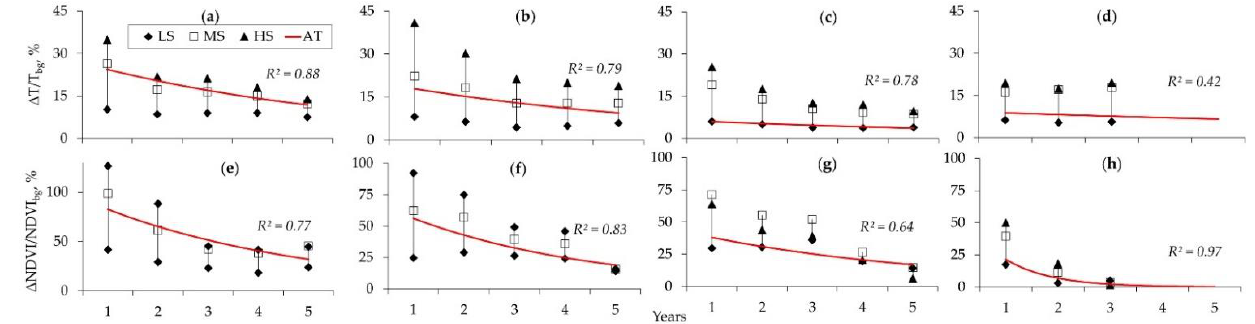
Figure 2. 5-year dynamics of ∆ T/T bg ( a – d ) and ∆ NDVI/NDVI bg ( e , f ) anomalies in post-fire plots in dominant tree stands: ( a , e ) Larch ( Larix sibirica ); ( b , f ) Scots pine ( Pinus sylvestris ); ( c , g ) Spruce ( Abies sibirica ); ( d , h ) Fir ( Picea obovata ). LS is a low degree of severity in terms of dNBR, MS is a moderate degree of severity, HS is a high degree of severity, and AT is an exponential approximation of the averaged values.